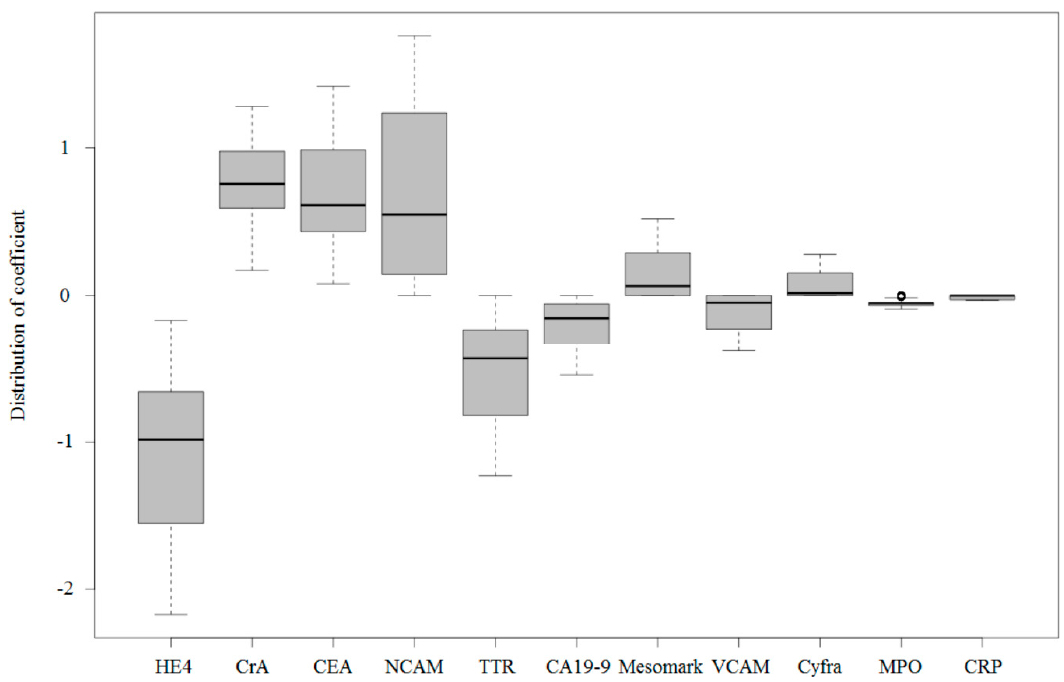
Figure 2. Distribution of the coefficient by the LASSO regression method. The y-axis is the distribution coefficient of the logistic regression model analyzed by the LASSO regression method. There are multiple values because the method was repeated 10-fold, with 2000 iterations of cross-validation. The mean value is in descending order from the left. As the absolute value is large, it will have a large coefficient from the model. In this sense, when the standard deviation of the measured value is changed to 1, it affects the results of the entire model. HE4 is the greatest contributor, followed by creatinine, CEA, NCAM, and TTR. There is large variation in the case of NCAM, and VCAM does not have a large contribution.